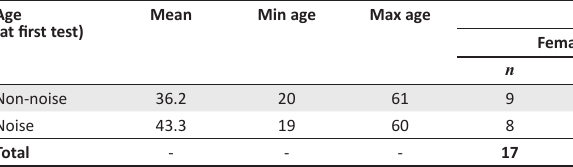
TABLE 1: Age, race and gender distribution of the 2583 gold mine workers. Age (at first test)